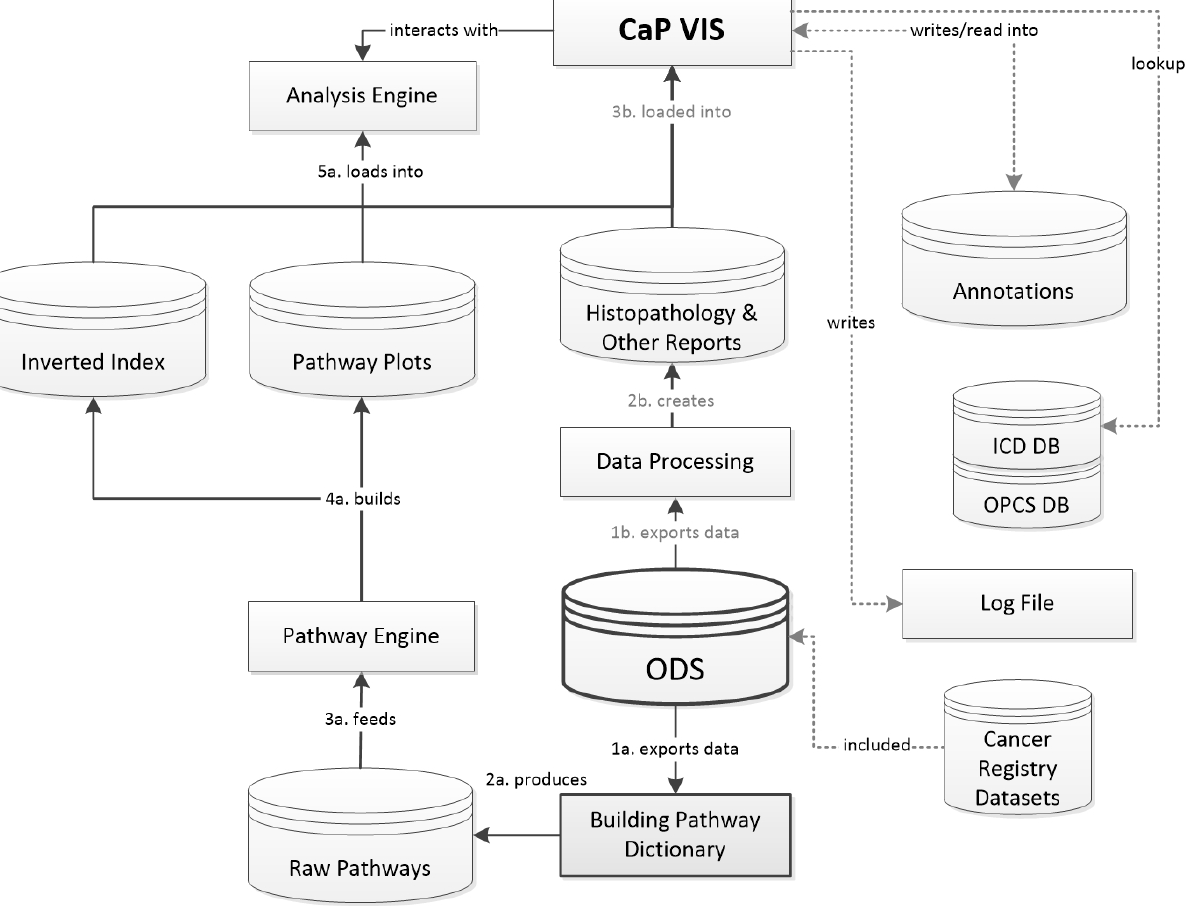
Figure 3. Data flow diagram illustrating the relationship between the operational data store (ODS, in bold), the pathway and analysis engine, the carcinoma of the prostate visualization and interpretation system (CaP VIS), and other interactions including lookup databases (DB) for International Classification of Diseases (ICD) and OPCS (Office of Population Censuses and Surveys) coding. The two main processes that feed information into the CaP VIS system are enumerated. The pathways data follows steps 1a to 5a, while other information follows steps 1b to 3b. Secondary processes are highlighted with dotted